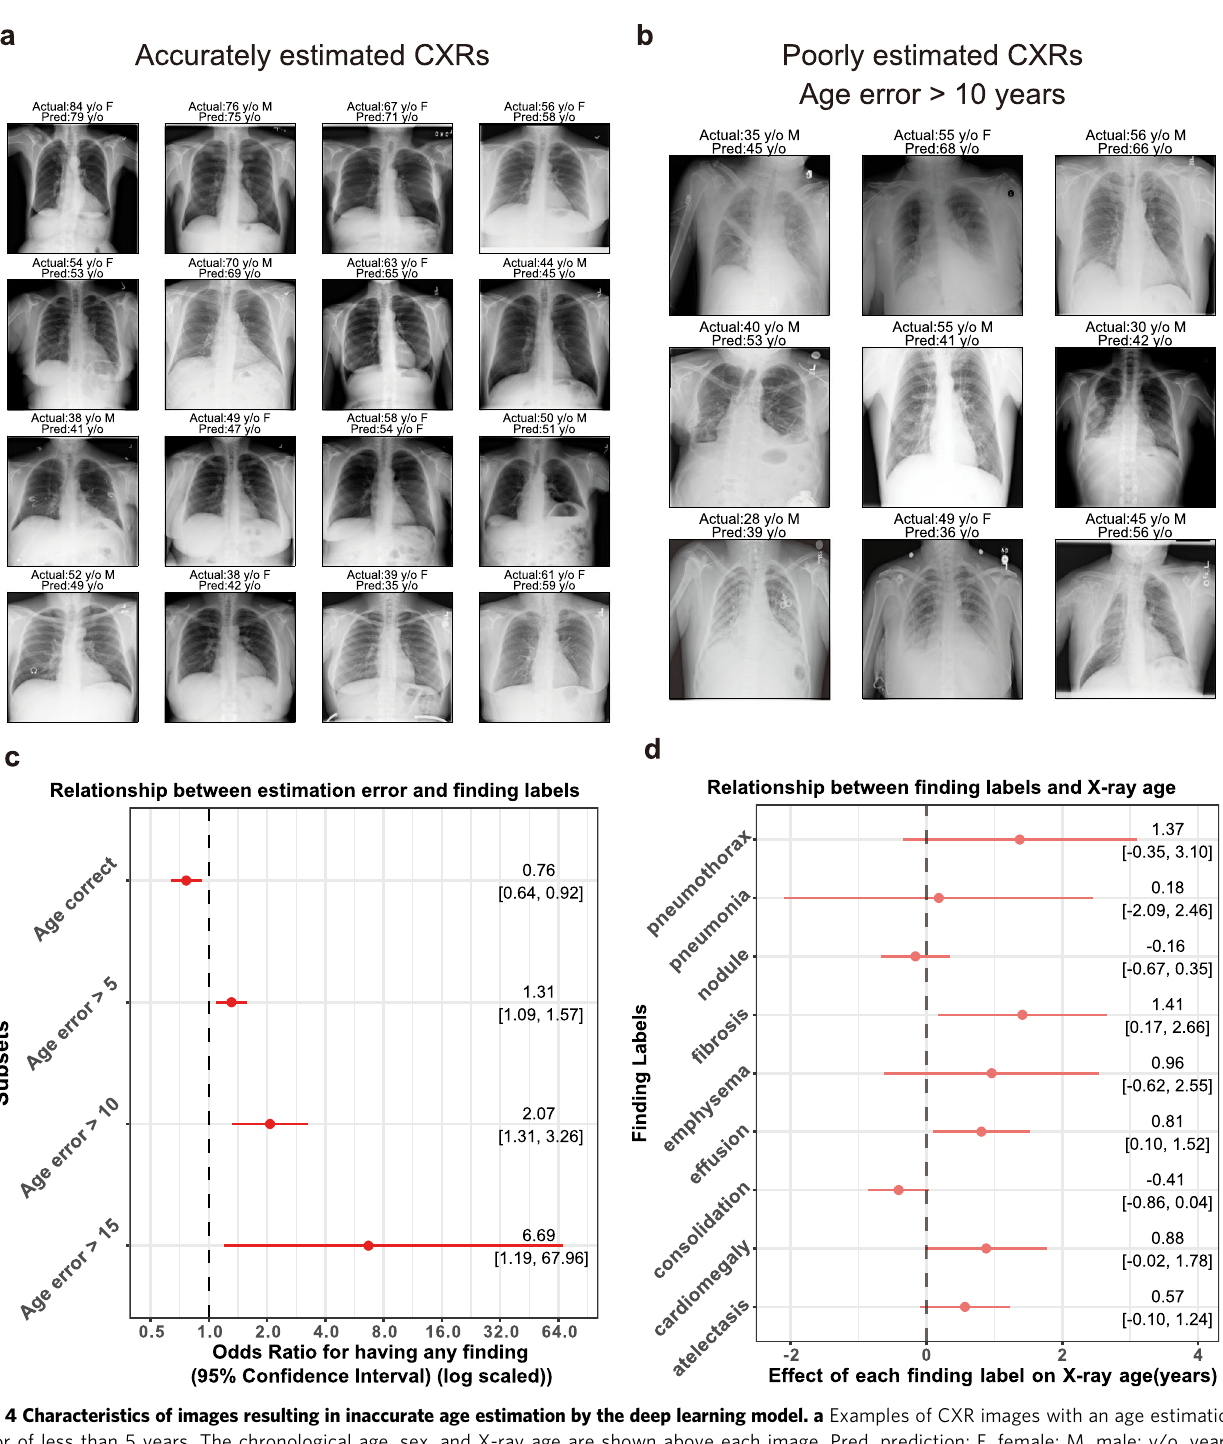
Fig. 4 Characteristics of images resulting in inaccurate age estimation by the deep learning model. a Examples of CXR images with an age estimation error of less than 5 years. The chronological age, sex, and X-ray age are shown above each image. Pred, prediction; F, female; M, male; y/o, years. b Examples of CXR images with an age estimation error of more than 10 years. c Relationship between age estimation error and presence of any fi nding labels. The odds ratio with a 95% con fi dence interval is shown on the x-axis ( n = 2773 independent X-ray images). The odds ratio of having any fi nding labels was lower in CXR images in which the deep learning model correctly estimated the age. On the other hand, images for which age could not be accurately estimated were signi fi cantly more likely to have fi nding labels. d Different fi nding labels that affect the patient ’ s estimated age. The effect of each fi nding label on the predicted age derived from linear regression adjusted for chronological age (see Methods) is shown on the x-axis ( n = 2773 independent X-ray images). For example, CXRs with the ‘ fi brosis ’ label are likely to be estimated 1.4 years older than the chronological